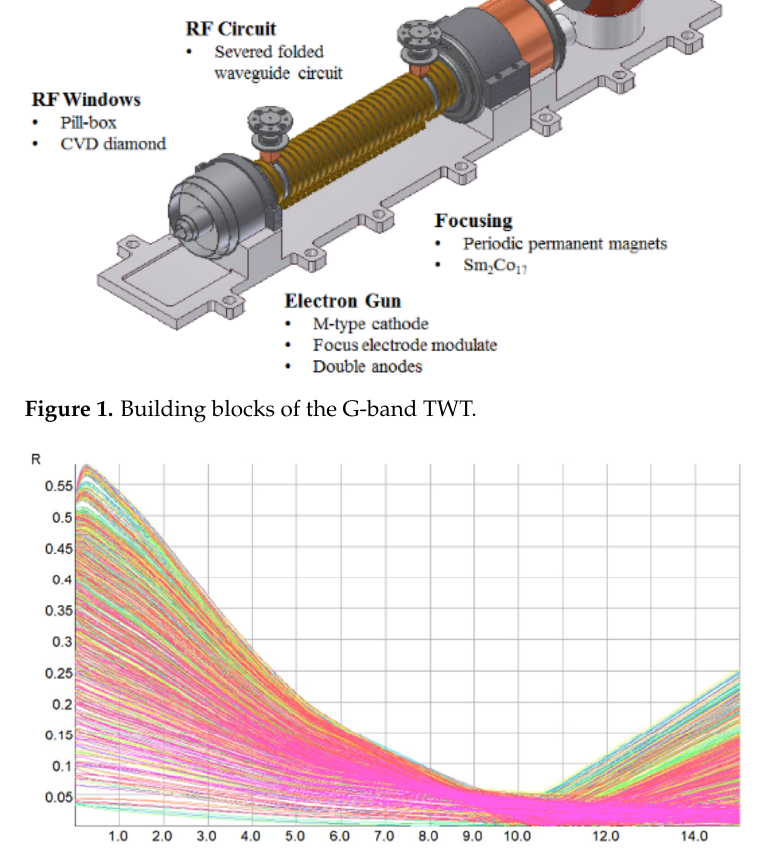
Figure 2. Simulation result of the electron gun.